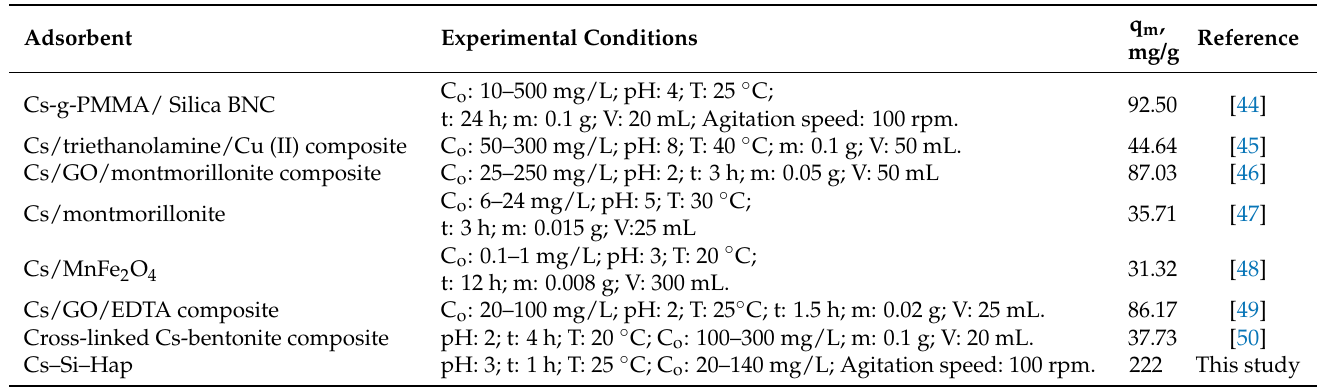
Table 3. Comparison of q m values for Cr(VI) adsorption on chitosan-based composites. Adsorbent